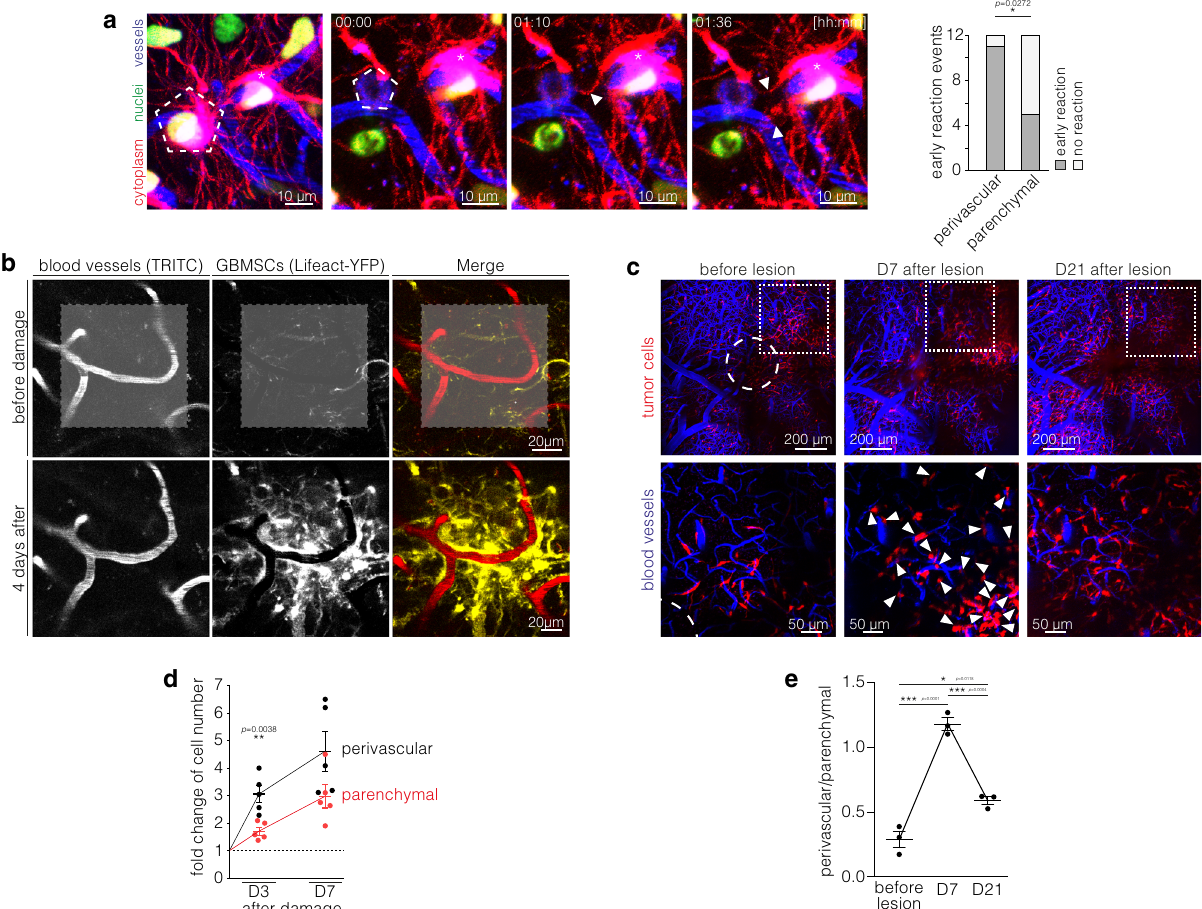
Fig. 5 Perivascular cells govern glioma ’ s damage response. a Left: Early reaction (white arrowheads) of a perivascular cell (asterisk) after laser ablation of a nearby S24 GBMSC (pentagon). Cytoplasm (red), blood vessels (blue), nuclei (green). Right: Analysis of the early reaction to laser ablation of nearby cells (S24 glioblastoma stem-like cells (GBMSCs), n = 12 events, two-sided Fisher exact test). b After laser-induced stress (marked with gray area in the upper row) a strong perivascular reaction can be observed (S24 GBMSCs). c Representative in vivo 2-PM images of the same region before, 7 and 14 days after a surgical lesion (circle) in a S24 xenograft tumor. 7 days after lesioning there is a strong increase of the perivascular cell population (arrowheads). Upper row: overview; lower row: subset. Subset regions are marked by dotted squares. d Fold changes of perivascular (black) and parenchymal (red) cell counts 3 and 7 days after laser damage compared to before laser damage (S24 GBMSCs, n = 5 regions in 4 mice, two-tailed t -tests) indicate that the damage response is predominated by the PVN. e Quanti fi cation of the ratio of perivascular and parenchymal cells before, 7 and 14 days after a surgical lesion (S24 GBMSCs, n = 3 animals, one-way ANOVA ( p = 3.92 × 10 − 5 ), Tukey ’ s post hoc test). This analysis reveals a shift towards the perivascular compartment that is most pronounced in the initial phase and precedes the repopulation of the lesioned brain area. Data d , e are represented as mean ± SEM. * p < 0.05, ** p < 0.01, *** p < 0.001. Source data are provided as a Source Data fi larger tumor area, repetitive scanning (950nm wavelength) for ~8 min with high laser power was performed. For the evaluation of therapeutic responses, the same tumor regions were imaged repetitively over 1 – 3 weeks. For invasion speed mea- surements and identi fi cation of invading tumor cells, single glioma cells were followed with repetitive imaging over 24h. Short-term residency of individual glioma cells was determined by repetitive imaging over 4 (S24) and 5 days (P3xx), long-term residency by repetitive imaging between D41 and D62.